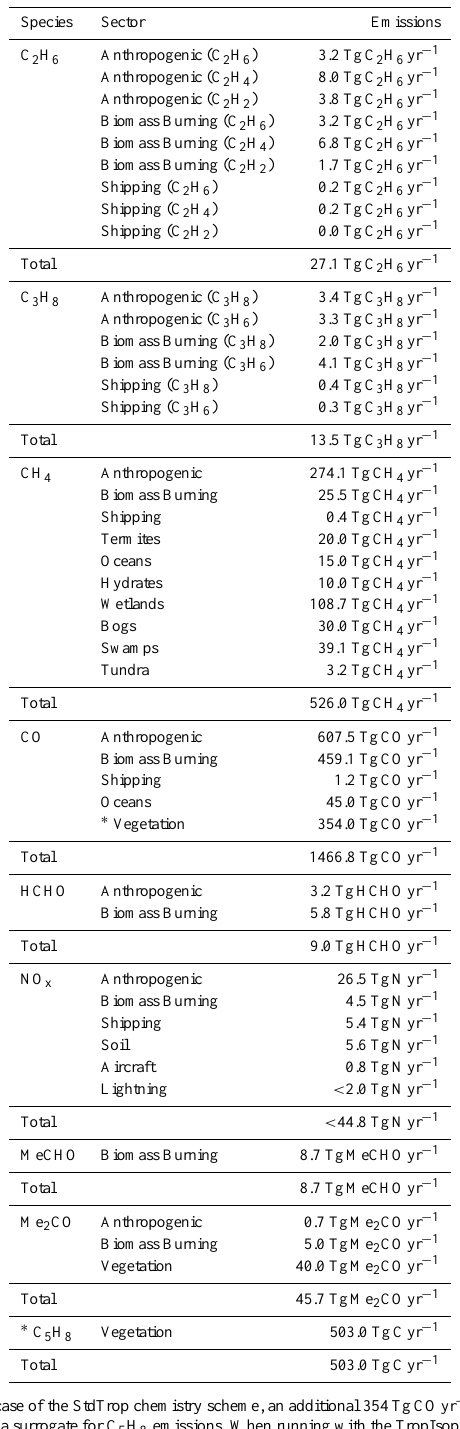
Table 11. Summary of the global annual emissions of trace gases used with the two chemistry schemes, StdTrop and TropIsop, in UKCA, where Me = CH 3